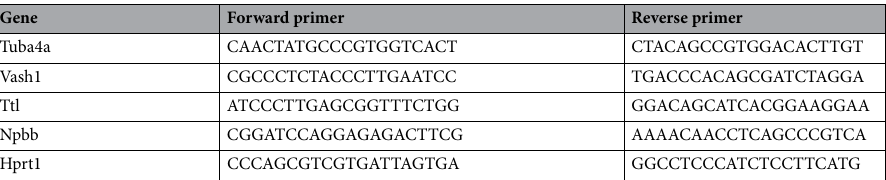
Table 2. Primers used for quantitative realtime PCR. Gene sequences of Tuba4a (coding for α-tubulin a4a), Ttl (coding for tubulin tyrosine ligase), Vash1 (coding for vasohibin1) and Npbb (coding for NT-proBNP) in LV tissue was detected by quantitative